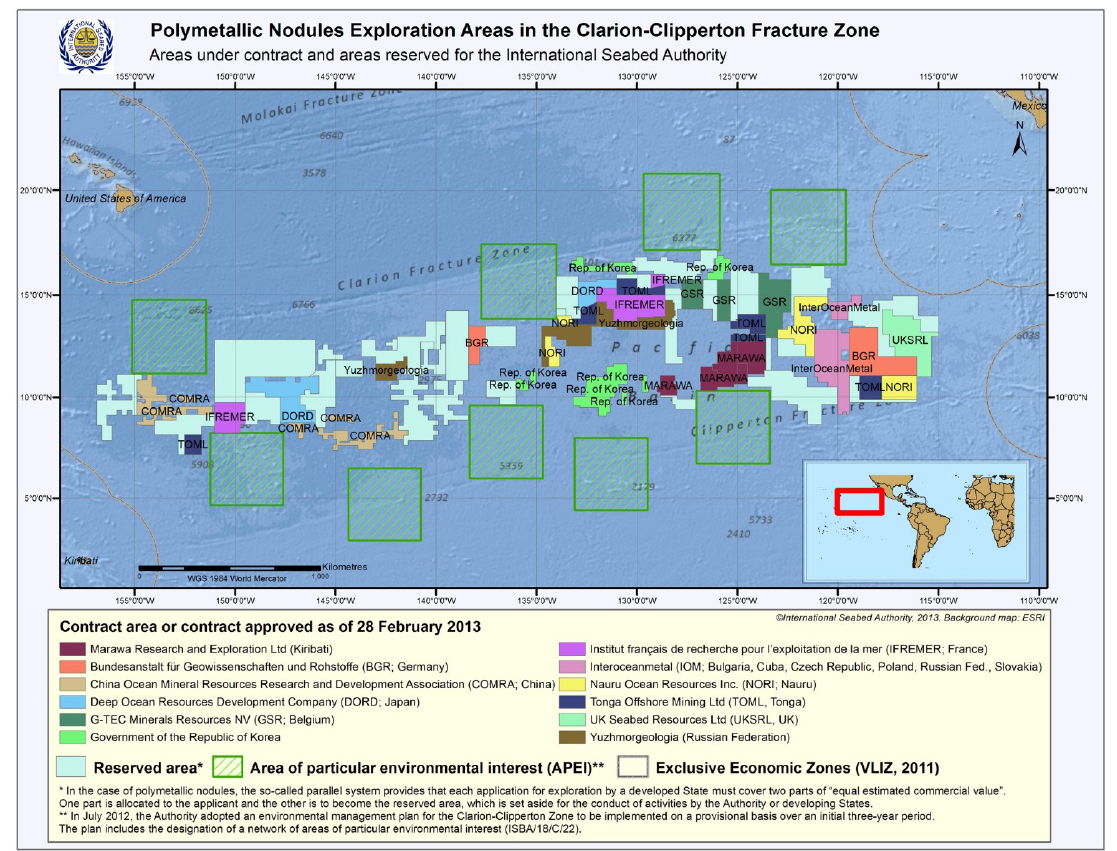
Figure 1. The Clarion-Clipperton Zone, central eastern Pacific, here illustrated with International Seabed Authority contracted polymetallic-nodule exploration claim areas as of February 2013, together with Areas of Particular Environmental Interest (current proposed, but not ratified, marine protected areas) over an approximately 6 million sq km region of the planet. Source: ISA [1].